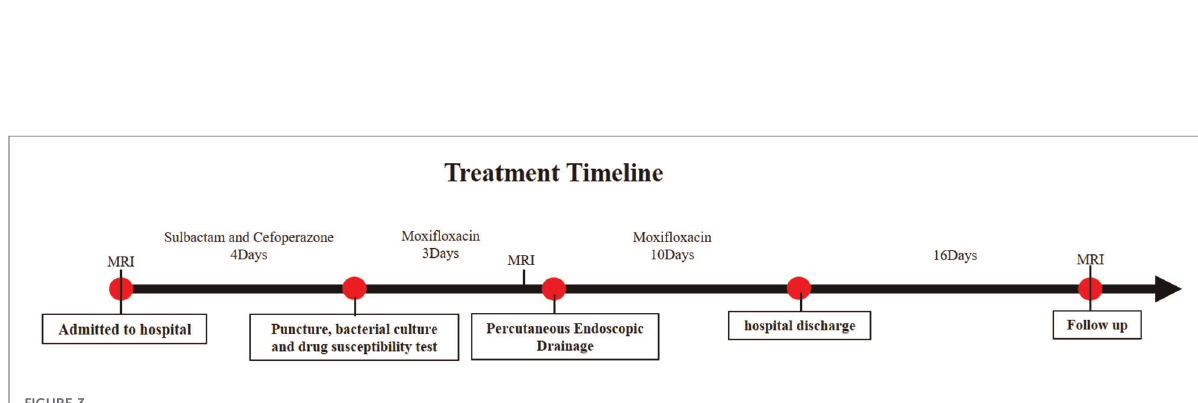
FIGURE 3 The treatment timeline of this